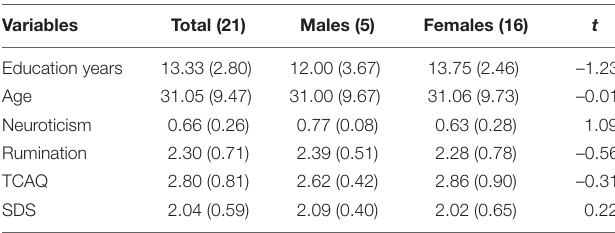
TABLE 5 | Descriptive statistics of main depression disorder (MDD) ( M, SD